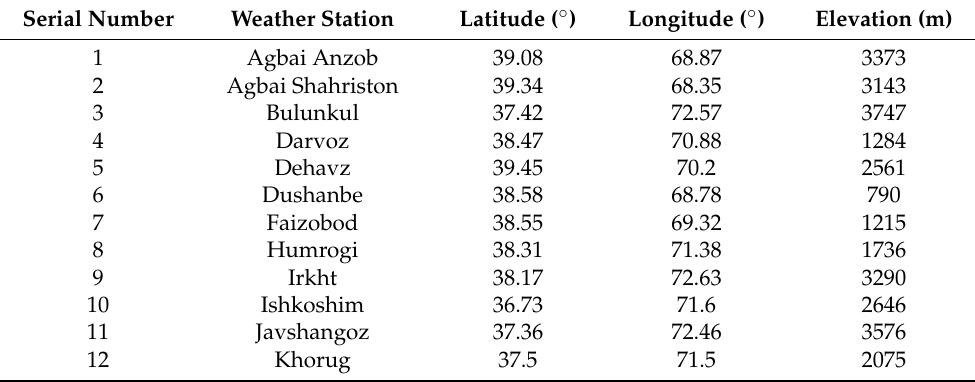
Table 1. Weather stations used in performance analysis of